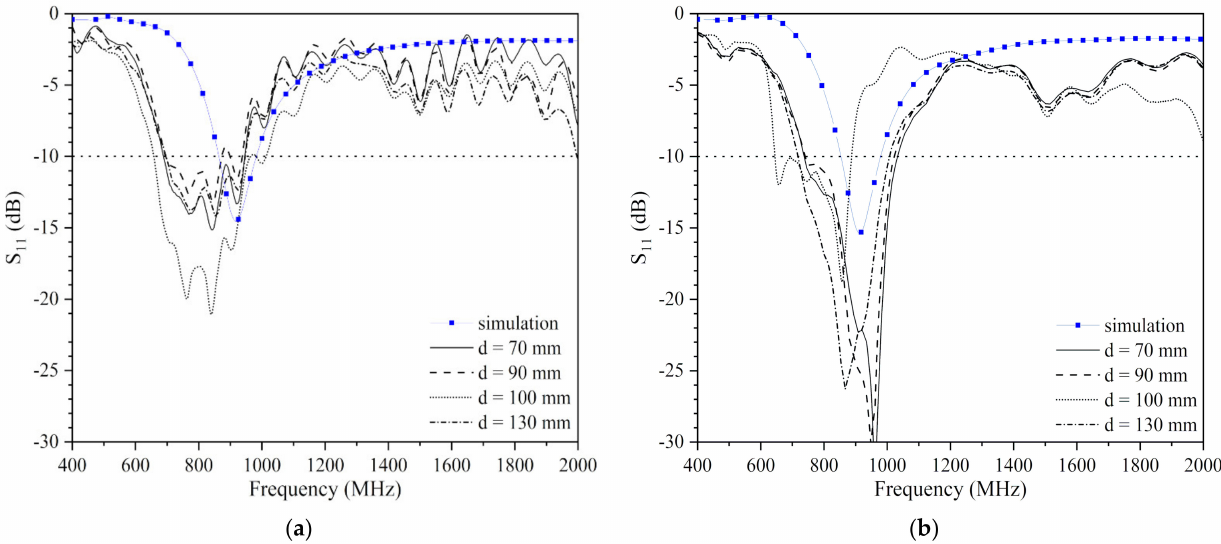
Figure 6. Measured magnitude of S 11 of the bow-tie antenna versus frequency. The antenna is bent, as shown in Figure 5c. ( a ) S1Ha and ( b ) B1Ha